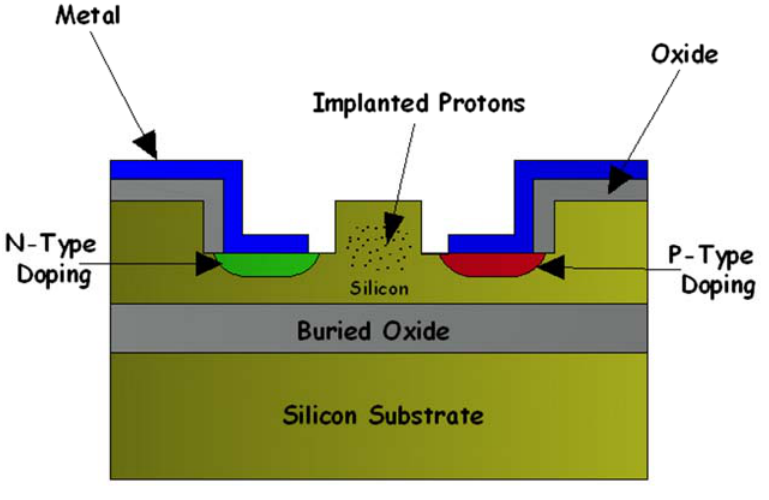
Figure 6. Monolithic p-i-n waveguide photodiode proposed by Knights et al. [46] in